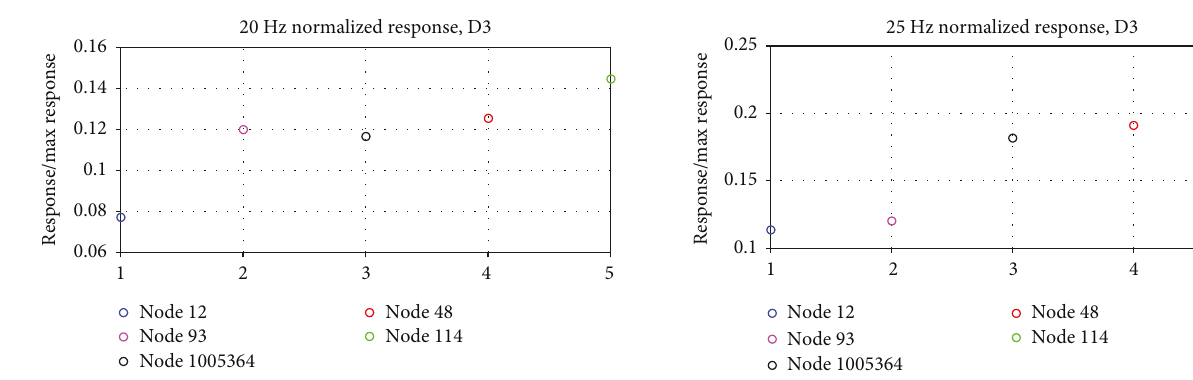
Figure 21: D3, 20Hz normalized responses, double excitation tests.